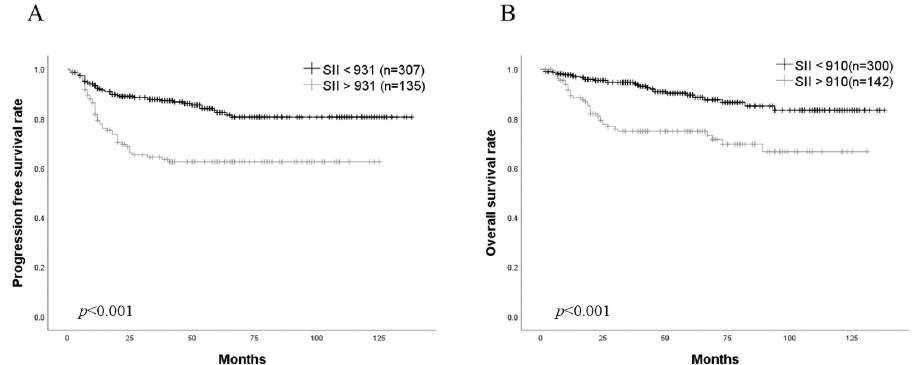
Fig 2. Kaplan-Meier estimates of survival in endometrial cancer patients based on SII. A, PFS. B, OS. Patients exhibiting higher SII showed significantly shorter PFS (p < 0.001) and OS (p < 0.001) than those exhibiting lower SII. The p-values were analyzed by log-rank test.